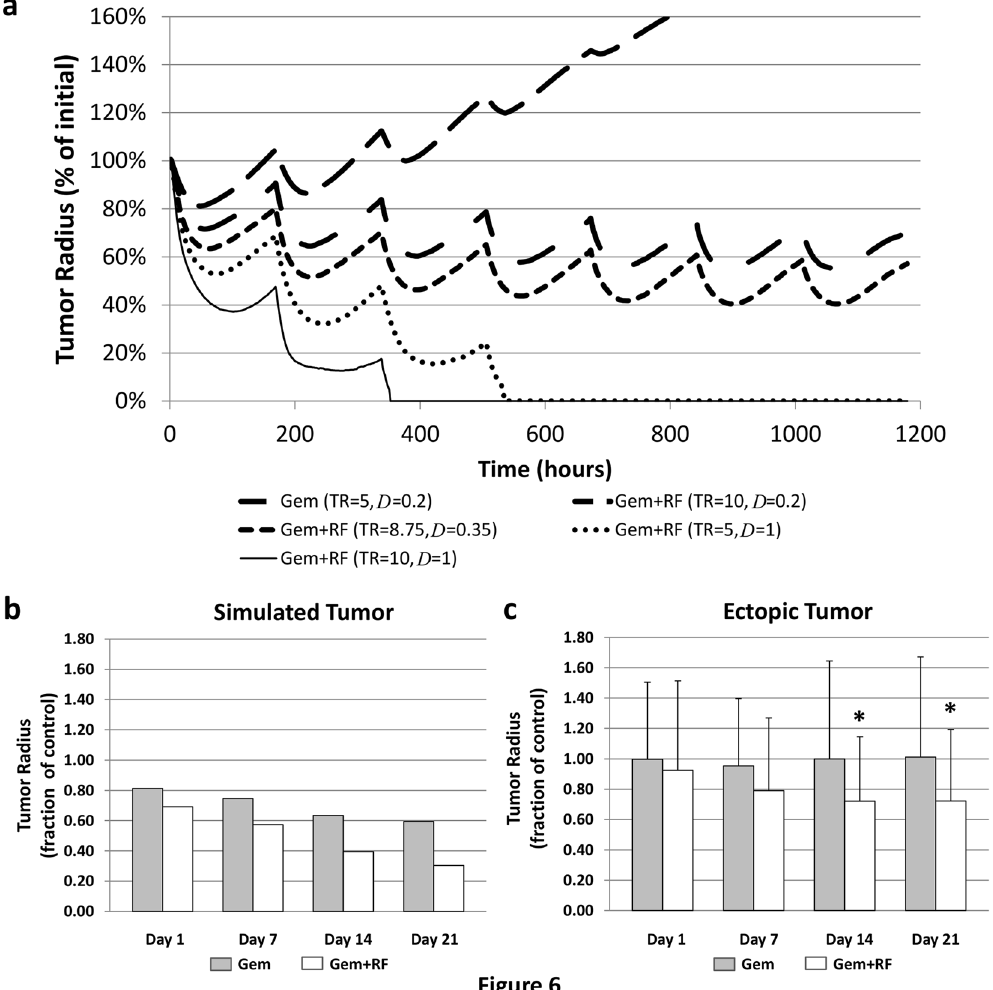
Figure 8. Simulation of weekly repetitive treatment for 7w with Gem or combination of Gem and non-invasive RF. ( a ) For Gem only case (topmost curve, large dash), lesion increases by 166% by the end of 6w compared to the initial size, while for Gem + RF assuming a 75% increase in drug diffusive penetration and vascular extravasation transfer rate (middle curve, short dash; calibrated from experimental data), the lesion is restrained after the 4 th treatment. TR: drug extravasation vascular extravasation transfer rate (for O 2 , TR = 5); D : drug diffusive penetration (for O 2 , D = 1.00). ( b ) Summary of tumor regression as fraction of untreated control predicted by the simulations assuming a 75% increase in drug penetration and transfer rate for Gem + RF. ( c ) Tumor regression measured as fraction of untreated control for PANC-1 ectopic tumors in mice in vivo (data from ref. 7). Mean ± SEM. Statistical significance ( * )determined using two-tailed Student’s t-test with significance level